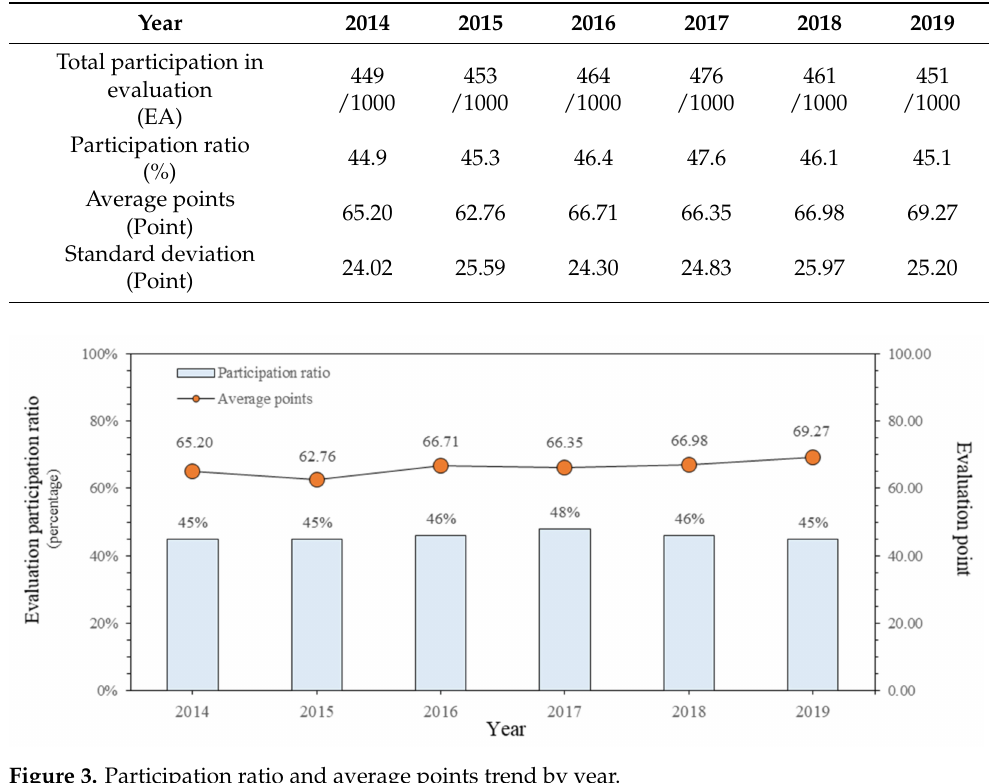
Figure 3. Participation ratio and average points trend by